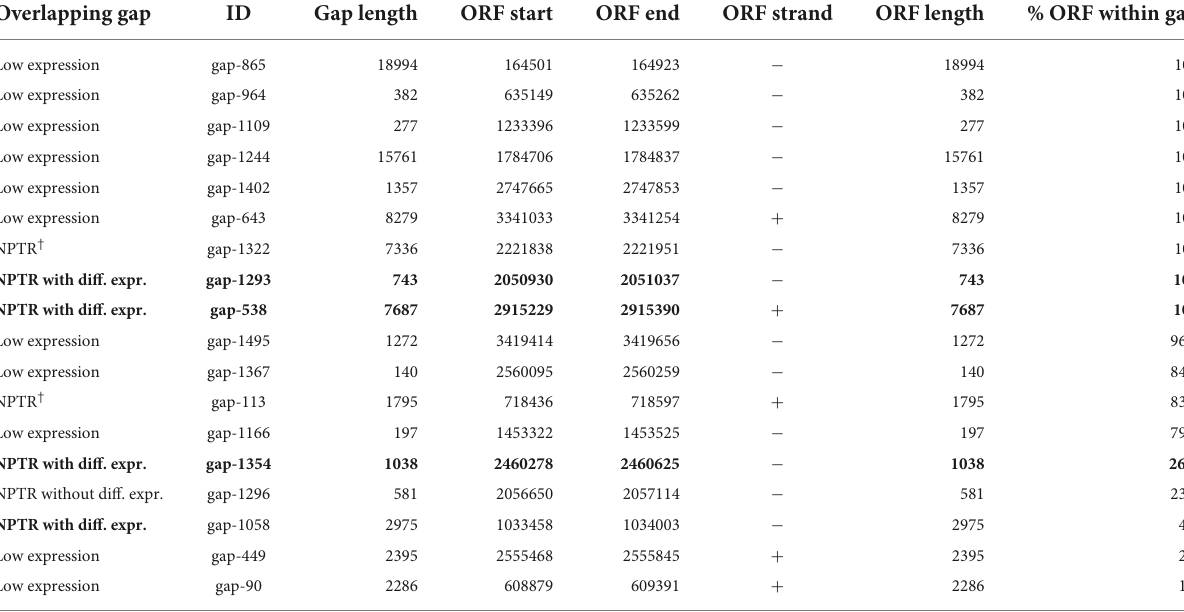
TABLE 3 ORF overlapping un-annotated